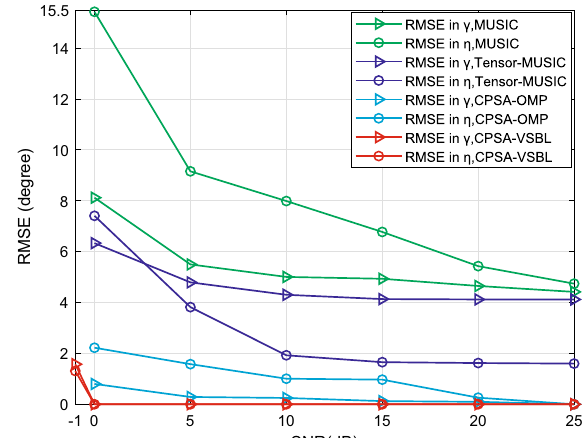
Fig. 7 The RMSE of γ and η versus